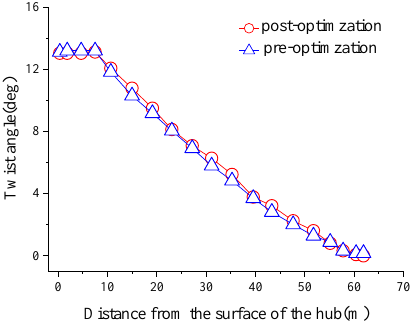
Figure 17. Distribution of the twist angle at mid-low wind speed before and after optimization.